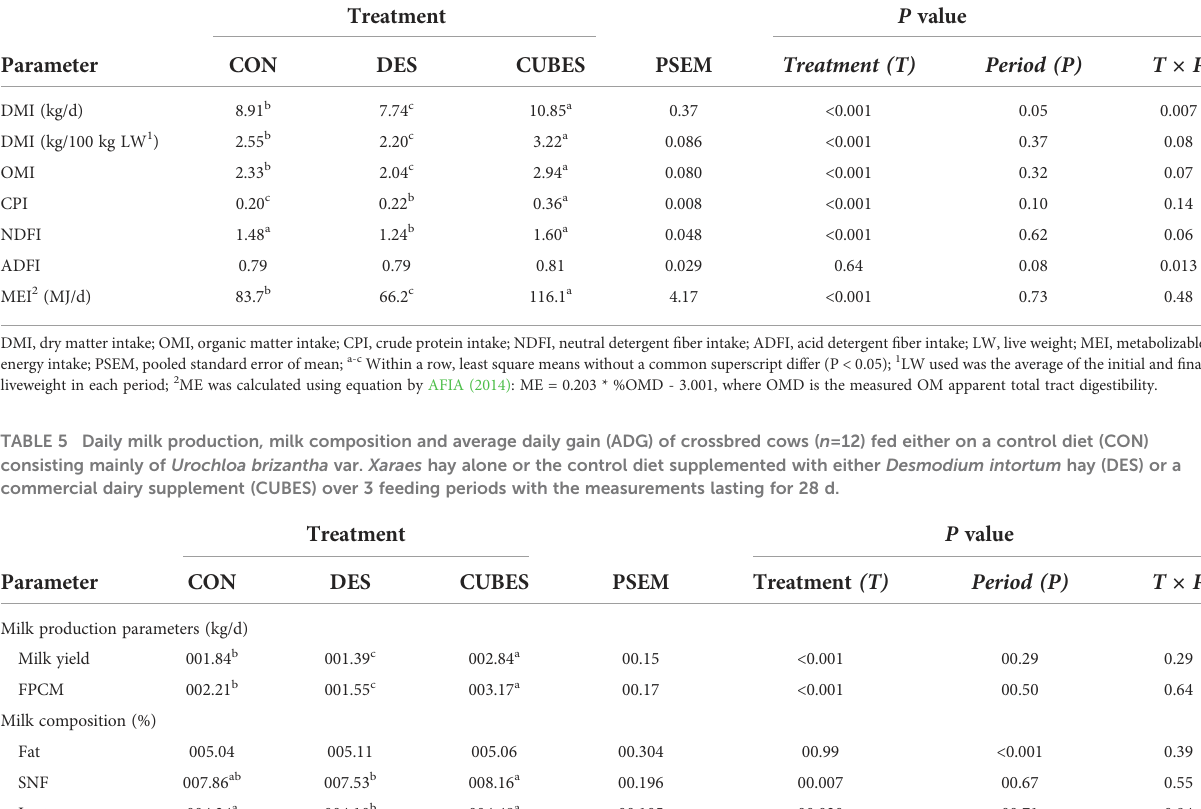
TABLE 4 Mean daily nutrient (kg/100 kg LW) and metabolizable energy intake (MJ/d) of crossbred cows ( n =12) fed either on a control diet (CON) consisting mainly of Urochloa brizantha var. Xaraes hay alone or the control diet supplemented with either Desmodium intortum hay (DES) or a commercial dairy supplement (CUBES) over three periods with each period lasting for 28